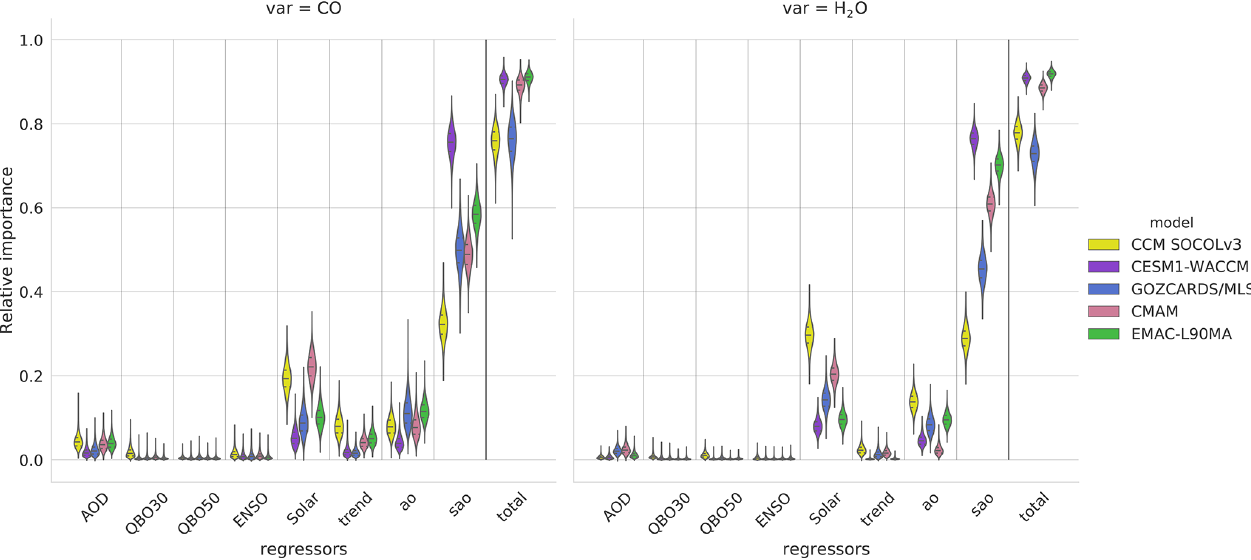
Figure 2. The full decomposition of R 2 from MLR of equatorial (30 ◦ N–30 ◦ S) CO for the period 2005–2017 and H 2 O for the period 1992– 2017 at 0.01hPa in the form of violin plots. For CO observations, the Aura/MLS data are used, and for H 2 O, the GOZCARDS composite are used. Distributions were calculated from 10000 bootstrapped samples using the LMG measurements. Horizontal dashed lines represent quartiles of the distributions. Note that to quantify relative importance of the annual (AO) and semiannual (SAO) oscillations, we do not use deseasonalized time